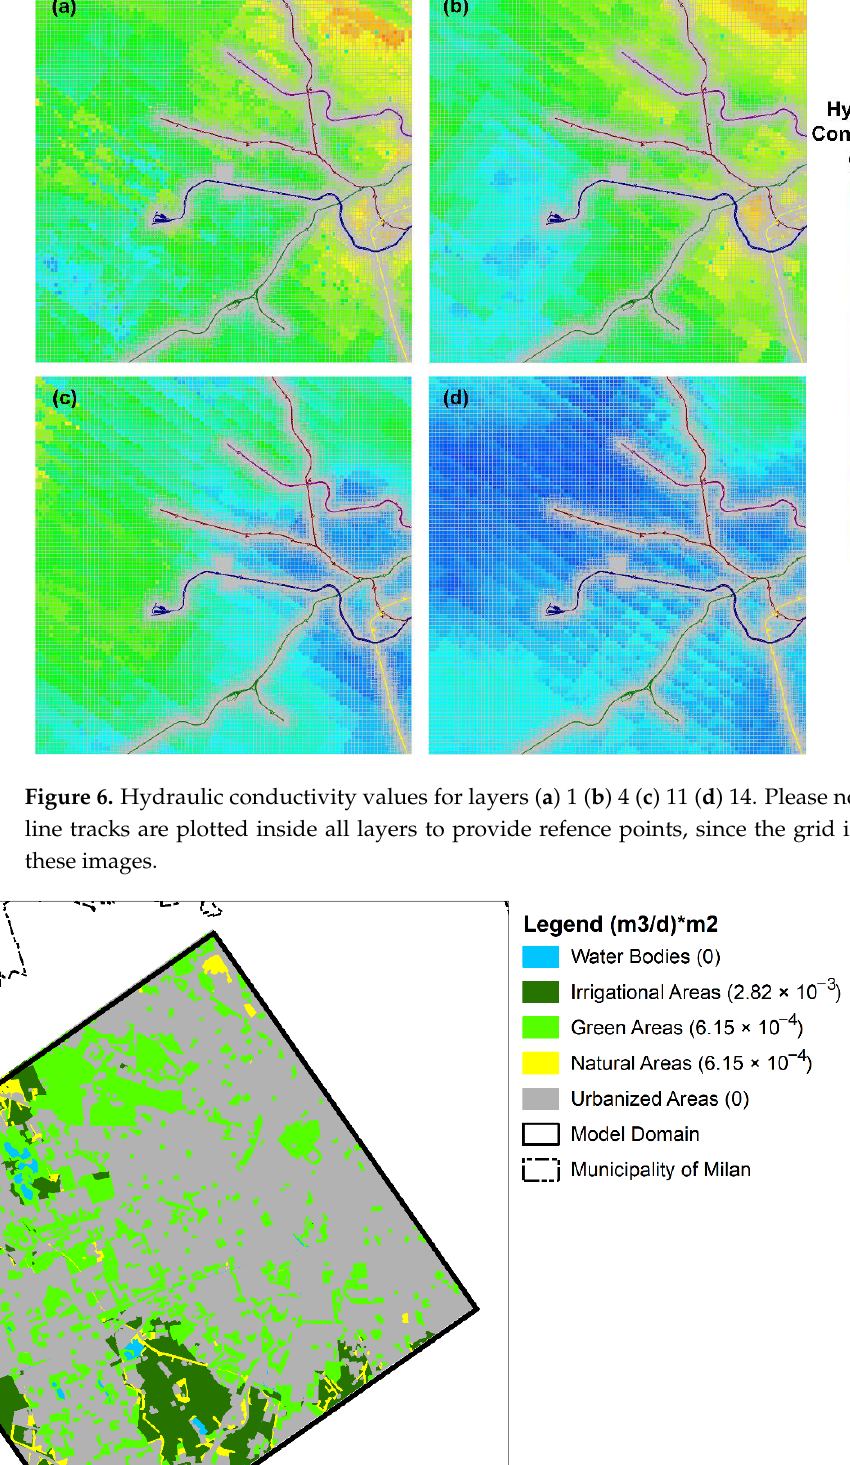
Figure 7. Areal distribution of the 5 recharge zones; final recharge values are provided in legend.